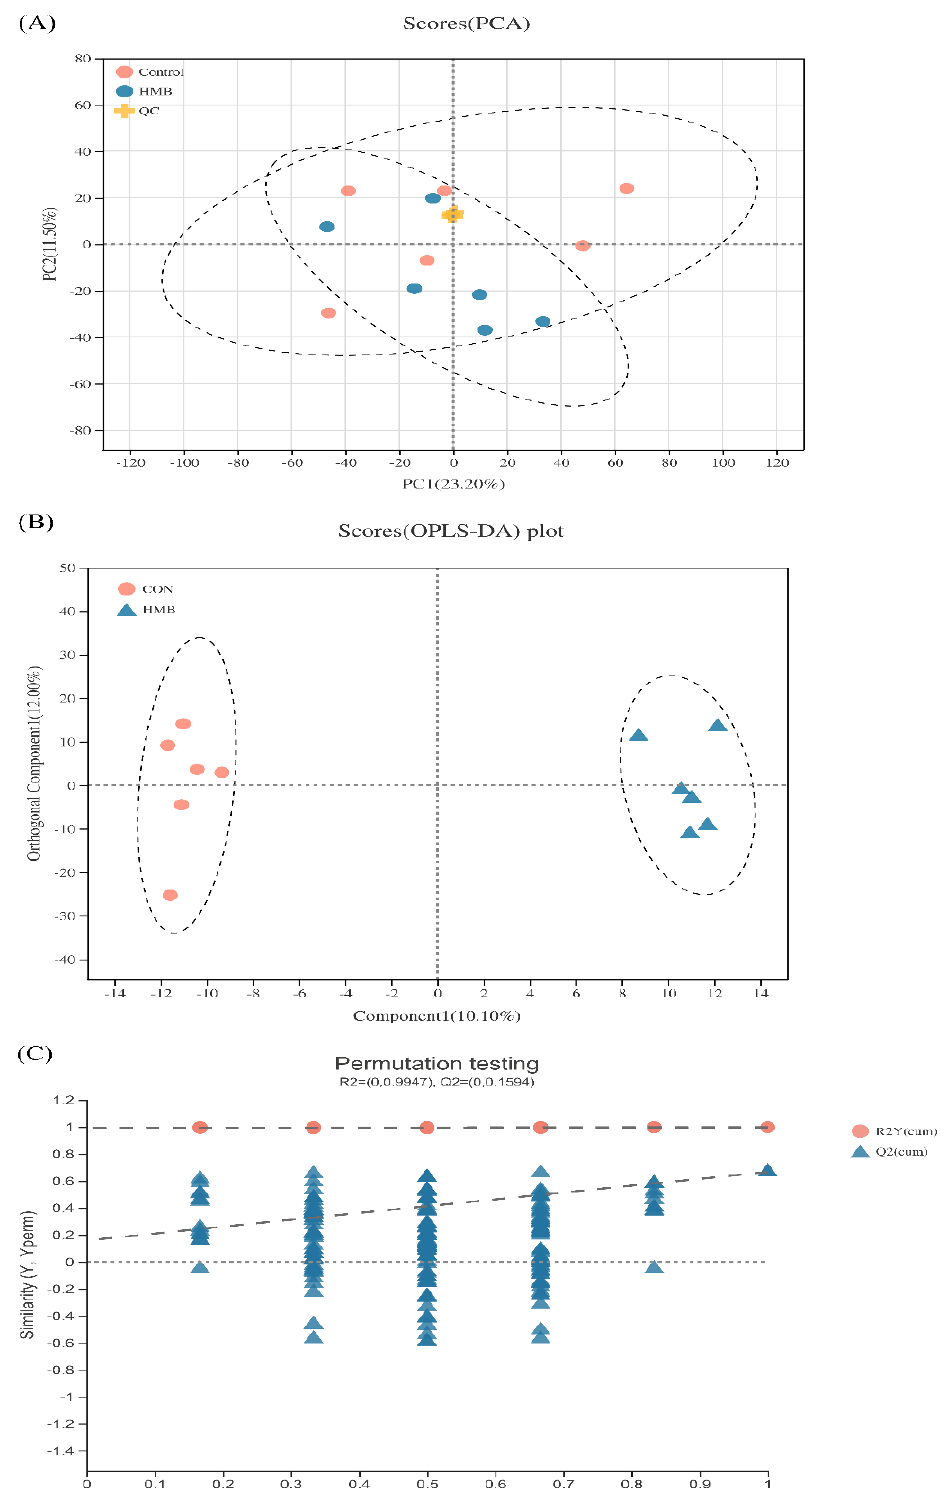
Figure 2. Principal component analysis (PCA) and orthogonal partial least-squares (OPLS-DA) score plots for serum metabolomics data ( n = 6). ( A ) Principal component analysis (PCA) score plots based on serum metabolite profiles. Variances captured by the first and second principal components (PC) are shown. PC1 = 23.20%, PC2 = 11.50%. ( B ) Orthogonal correction partial least squares discriminant analysis (OPLS-DA) score plots for serum metabolite profiles. Through orthogonal rotation, OPLS-